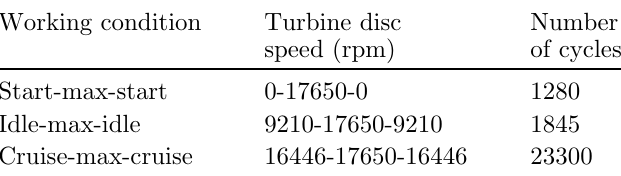
Table 9. Cyclic load spectrum of turbine